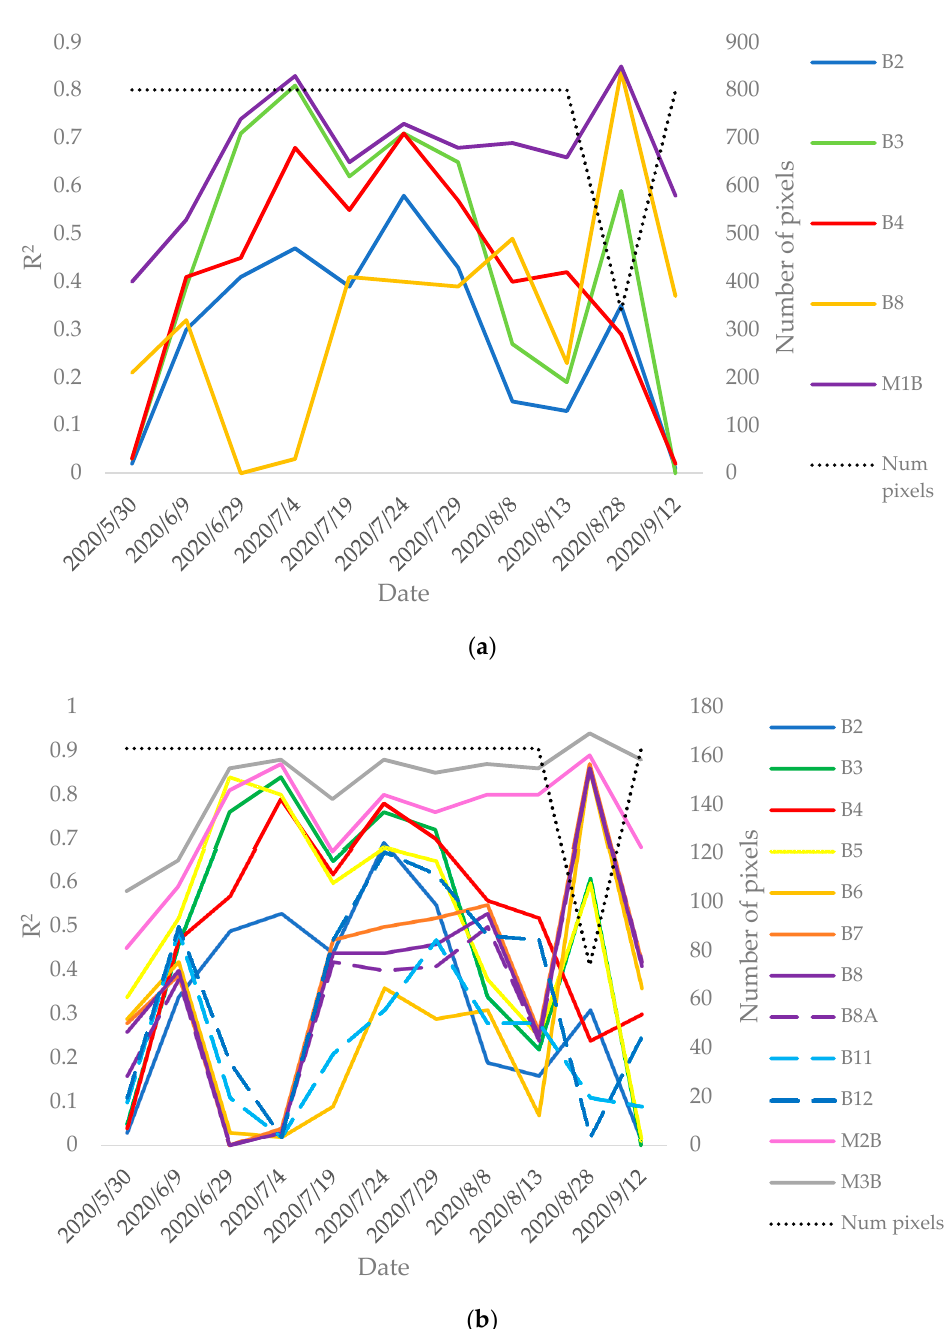
Figure A2. Coefficient of determination timeseries evolution focusing on Bomba training data of each band at 10 m ( a ) and at 20 m ( b ) spatial resolution and the linear combination of all of them against the final yield at pixel level (M1B, M2B and M3B). Additionally, the number of pixels is added as a reference of the cloud situation.